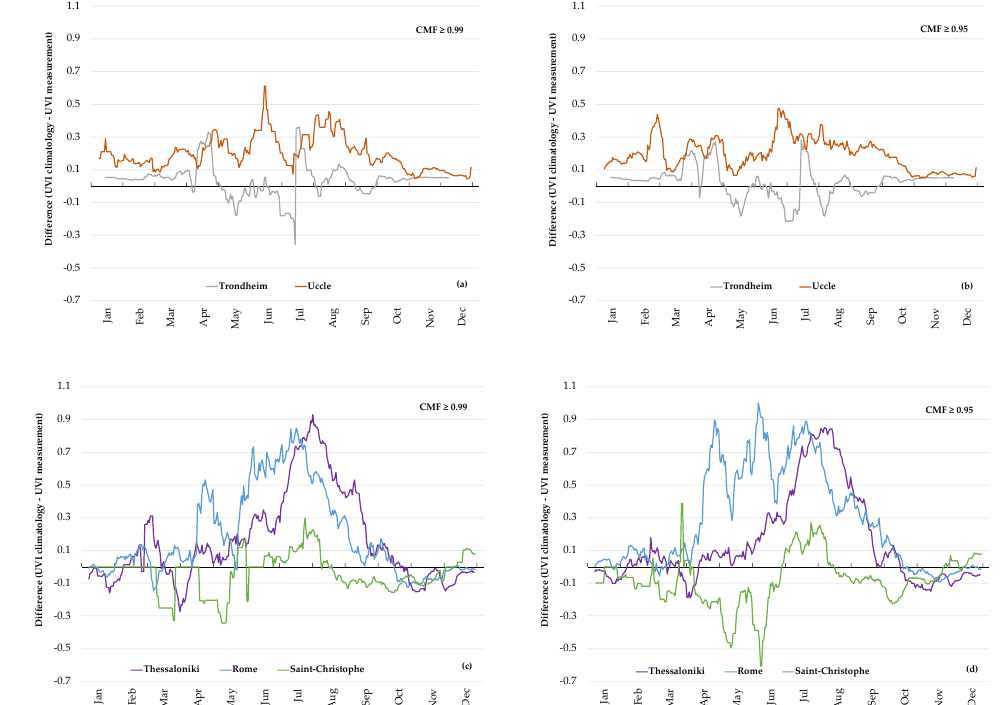
Figure 12. Mean difference between the noontime satellite-based UVI from the climatology and the noontime ground-based UVI measurements in Saint-Christophe, Rome, Thessaloniki, Trondheim and Uccle on nearly clear sky days with cloud modification factor CMF ≥ 0.99 ( a , c ) and days with CMF ≥ 0.95 ( b , d ) during the time period 2005–2015, shown as smoothed averages for a ±7 days